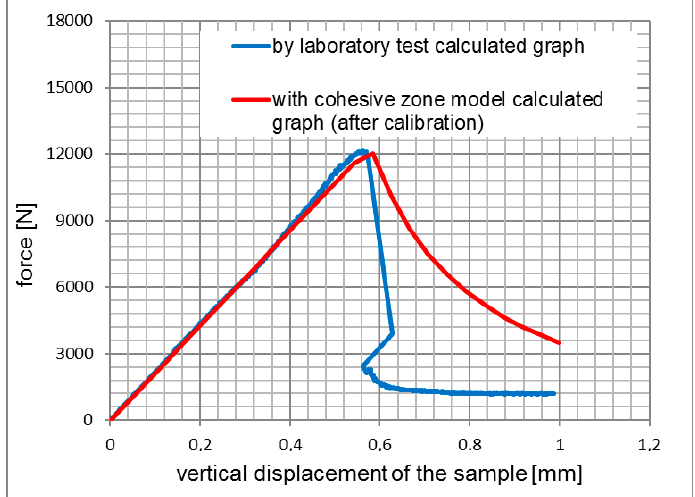
Figure 6. Comparison of the force-displacement curves from asphalt binder layer.